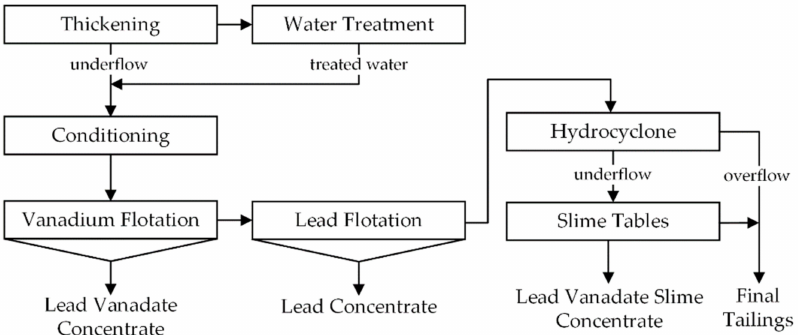
Figure 2. Flowsheet of the processing plant at Abenab West Mine, Namibia, Part 2